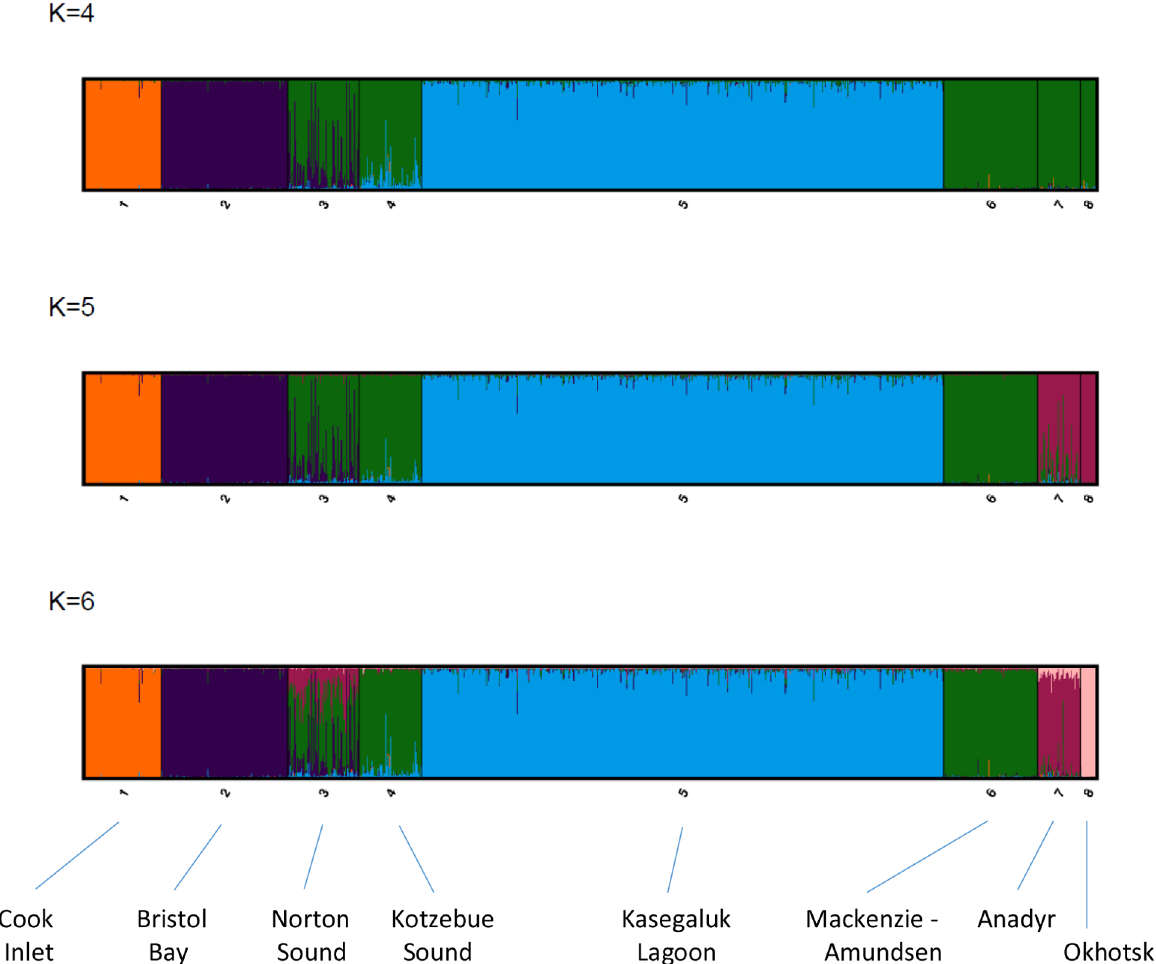
Fig 3. Summary plots generated in C LUMPAK of model-based cluster analysis of population structure in Pacific beluga whales using STRUCTURE 2.3.4. The major modes for K = 4 to 6 (based on five separate runs for each value of K ) are presented for the analysis using prior sample group information and no admixture which revealed K = 5 clusters as the most likely (see panel 2). However, in a number of analyses K = 6 was the most or second-most likely resulting in the separation of Anadyr into a discrete cluster (see panel 3). Each genotyped individual is represented by a vertical line with estimated membership, Q, in each cluster denoted by different colors. The analysis was based on using all individuals (n = 1032) scored at 6 or more loci (n loci (cid:21) 6).